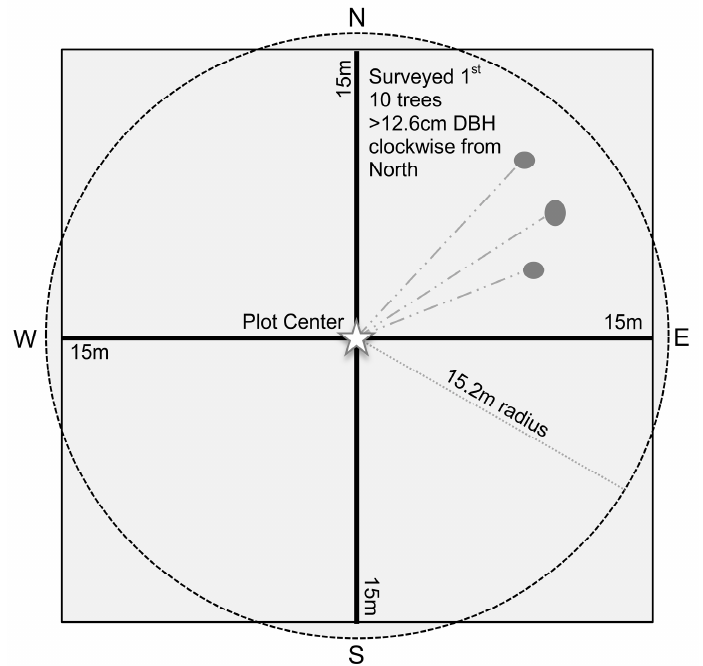
Figure 2. Diagram of the 2014 field sampling protocol. Table 1. Plot-level topographic, vegetative, and fire effects variables.